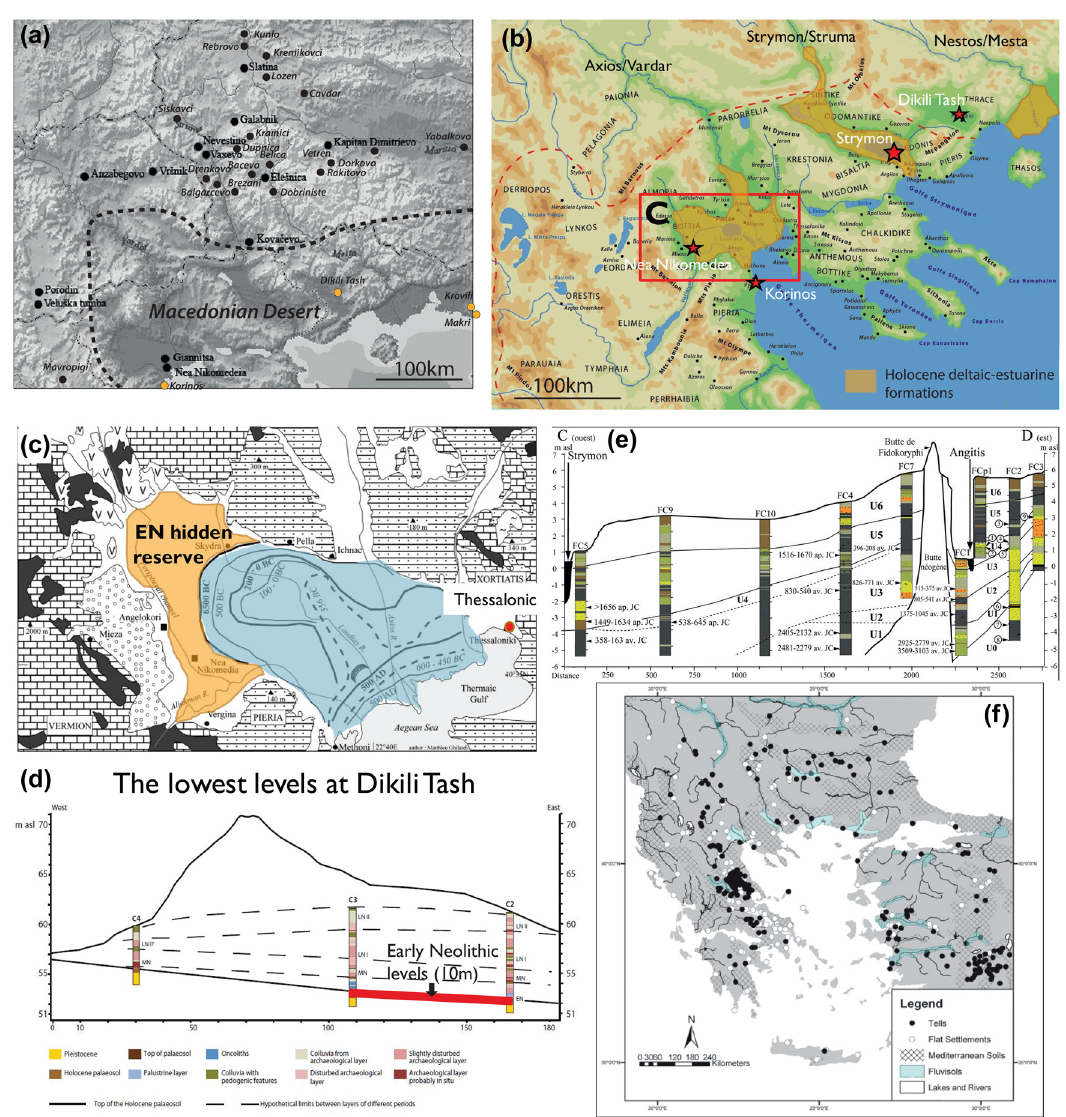
Figure 6: The Macedonian Desert, the geo - archaeological exploration of the vast north Aegean estuaries and the regional Early Neolithic distribution. ( a ) Map of the Macedonian Desert ( black dashed line ) with the few coastal EN sites ( orange circles ) . The deep estuaries and deltas are represented as fl at dark grey coastal areas ( modi fi ed from Nikolov, 2007 ) . ( b ) Position of the few EN discoveries in Macedonia between Korinos and Dikili Tash, with the cartography of Holocene deltaic - estuarine formations. ( c ) Location of the Nea Nikomedea tell, in the southern part of the vast Axos/Vardar - Aliakmon delta ( modi fi ed after Ghilardi et al. 2012 ) and proposal for an EN hidden reserve set behind the maximum transgressive shoreline. ( d ) Early Neolithic 1 horizon ( 6500 – 6200 BC ) ( red unit ) at 10 m deep in the Dikili Tash swamp ( after Lespez et al., 2013 ) . ( e ) Cross section of the lower Strymon valley with position of the Late Neolithic fl uvio - estuarine horizons ( U0 and U1 ) at a depth of more than 8 m in the eastern part of the valley, close to the Angitis tributary course ( after Glais et al., 2017 ) , illustrating the di ffi culties of identifying Early Neolithic horizons on the Macedonian coastline. ( f ) Regional spatial distribution of EN sites in SE Europe and western Turkey, with tells and fl at settlements, and two di ff erent soils units ( fl uvisols and red Mediterranean soils; after Rosenstock 2002 ) ; with four or fi ve exceptions, the mapped sites do not coincide with fl uvial and deltaic sedimentary areas covered by fl uvisols. Holocene stable areas ( without sedimentary deposits ) , covered by red soils in contrast, contain a large number of EN sites, easily detectable on the